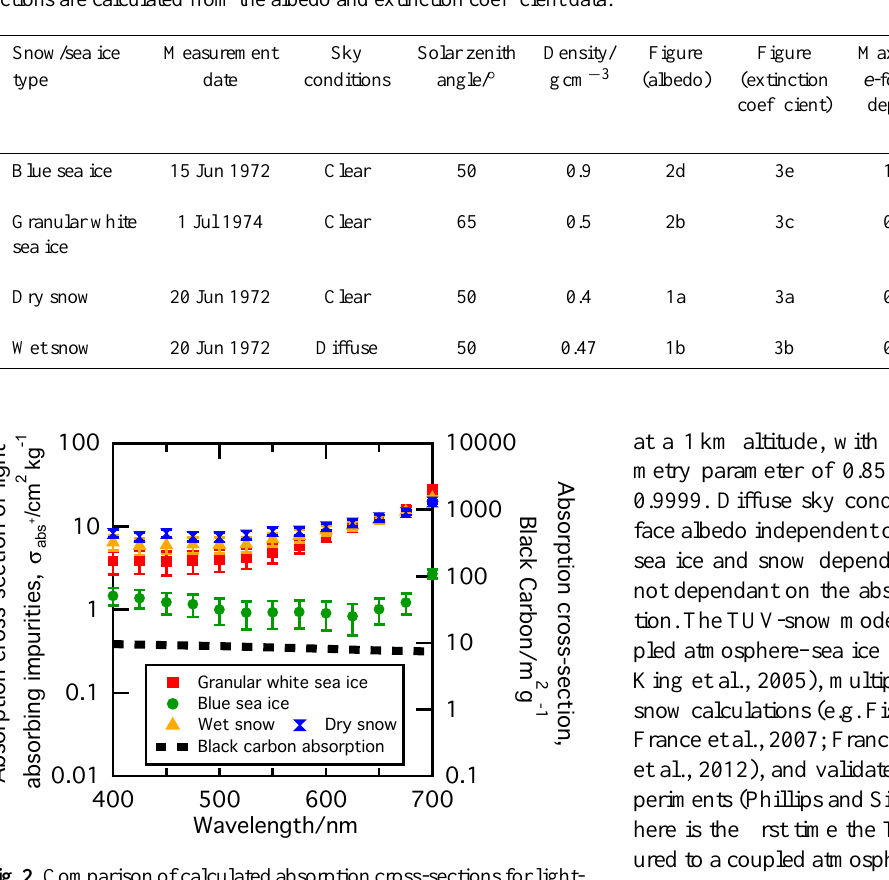
Fig. 2. Comparison of calculated absorption cross-sections for light- (λ) , in granular white sea ice, blue sea ice, absorbing impurities, σ + abs wet snow and dry snow. Error bars show the average difference in calculated absorption values through making small changes to the data fit for obtaining these values. The absorption cross-section of black carbon and the absorption cross-section of the light-absorbing impurities is per kg of sea ice.